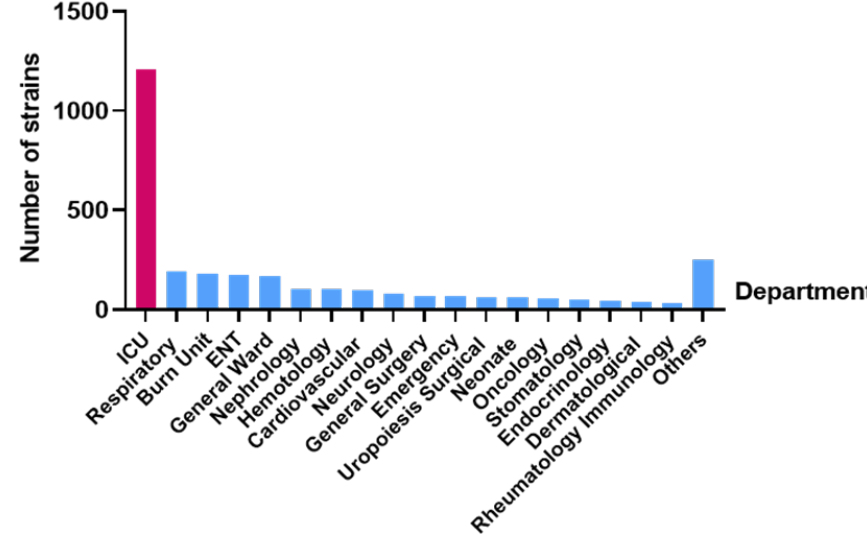
Figure 2. Distribution of main departments of 3036 patients infected by P.